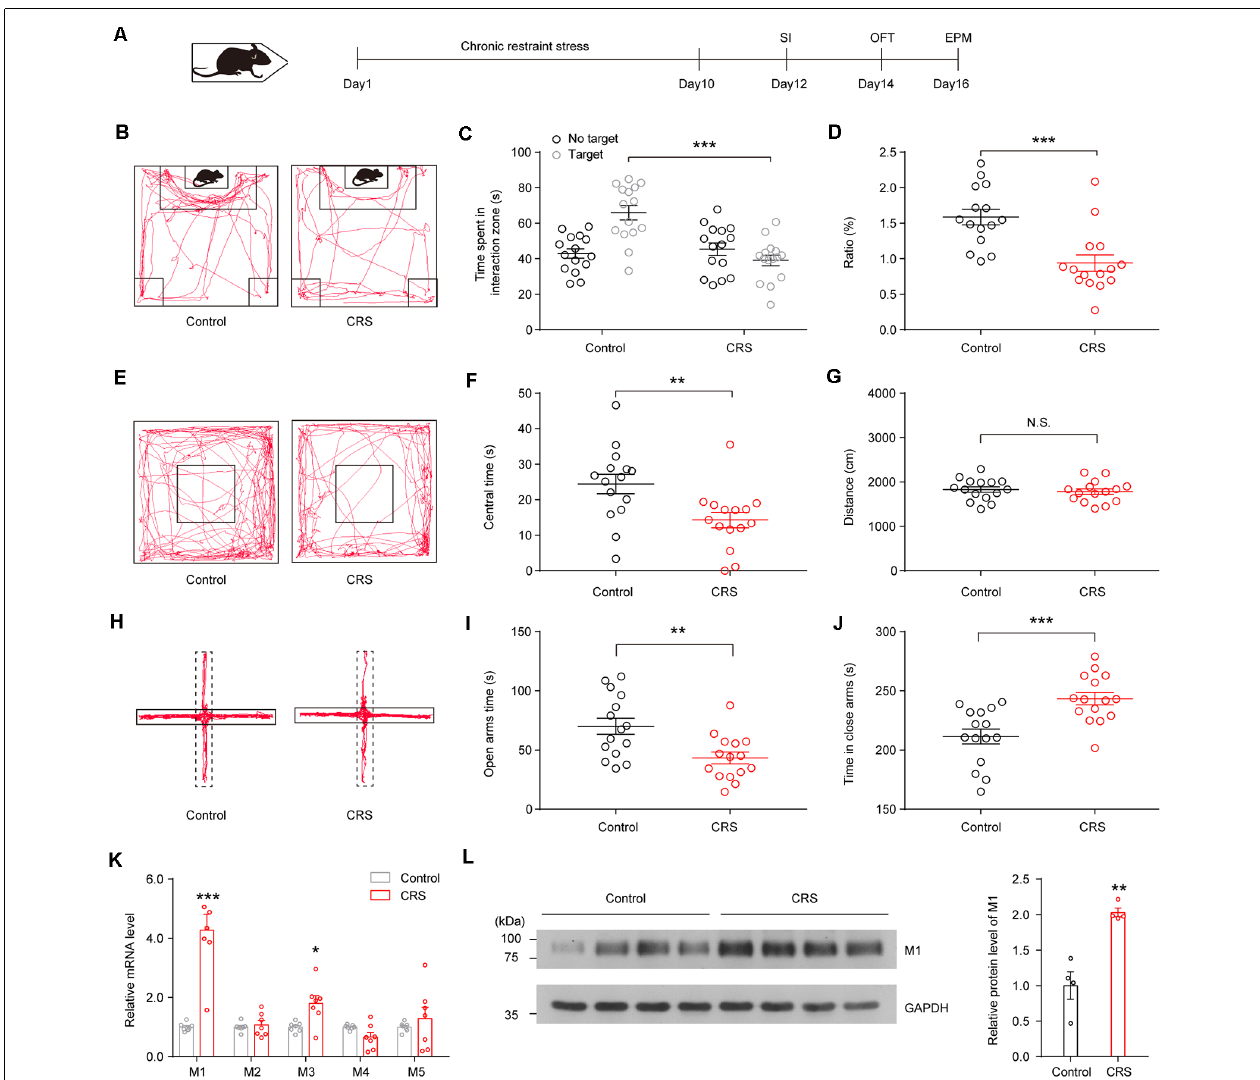
FIGURE 1 | Chronic restraint stress (CRS) induces social avoidance and anxiety-like behaviors and increases acetylcholine (ACh) muscarinic receptor (mAChR) expression in ventral hippocampus (vHPC) in mice. (A) CRS procedure: mice were restrained for 2 h/day for 10 days and subsequently subjected to behavioral tests. (B) Representative tracks of control and stress group in social interaction (SI) test. (C) SI time in the absence or presence of social target. Two-way analysis of variance (ANOVA), F (1,56) = 5.631, p < 0.001. (D) The ratio in the SI test was decreased in the CRS group. Unpaired two-tailed Student’s t -test, t (28) = 4.086, p < 0.001. (E) Representative tracks of control and stress group in the open-field test (OFT). (F) Mice after CRS spent more time in the center area of the OFT. Unpaired two-tailed Student’s t -test, t (28) = 2.899, p = 0.0072. (G) Control and CRS mice showed no difference in total distance. Unpaired two-tailed Student’s t -test, t (28) = 0.5412, p = 0.5927. (H) Representative tracks of control and stress group in the elevated plus maze (EPM). (I) Mice after CRS spent less time in the open arms of EPM. Unpaired two-tailed Student’s t -test, t (28) = 3.183, p = 0.0036. (J) Mice after CRS spent more time in the closed arms of EPM. Unpaired two-tailed Student’s t -test, t (28) = 3.915, p < 0.001. (K) The mRNA expression of different mAChR subtypes in the vHPC in control and CRS mice. Unpaired two-tailed Student’s t -test. (L) The protein levels of M1 were increased in the vHPC of CRS mice. Unpaired two-tailed Student’s t -test, t (6) = 5.097, p = 0.0022. The data are presented as the mean ± SEM, N.S.: not significant, * p < 0.05, ** p < 0.01, *** p < 0.001. The numbers of mice are shown in parentheses.